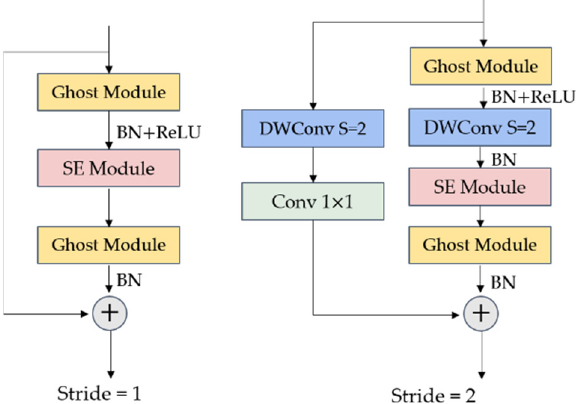
Figure 6. Bottleneck with SE module.